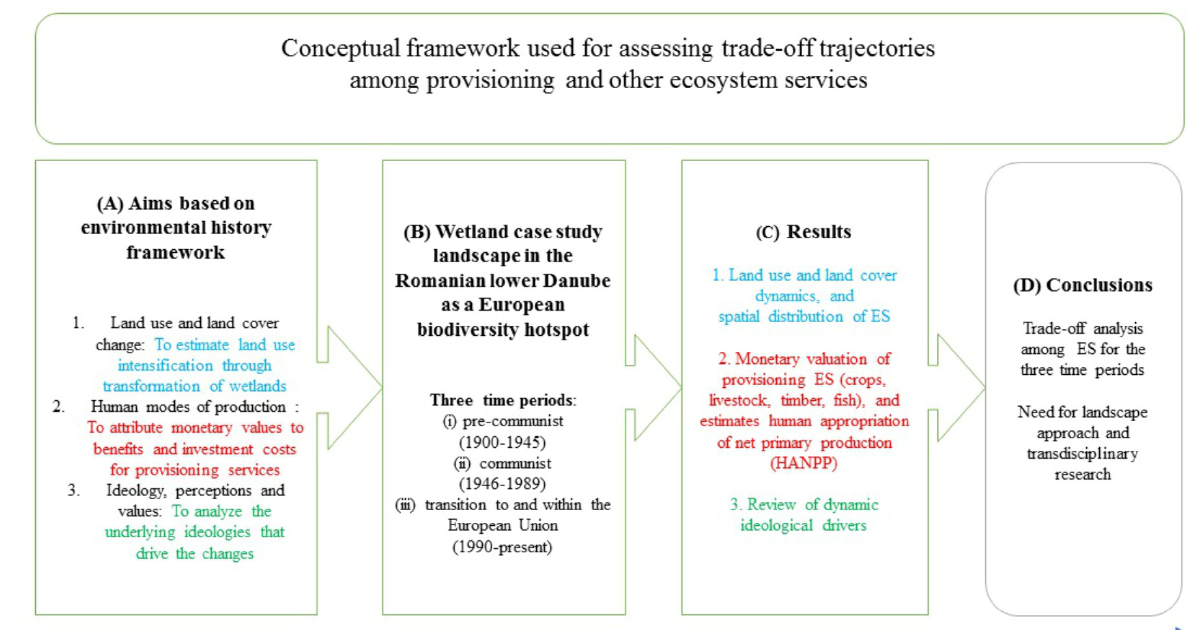
Figure 1. Overview of the research process that aimed to ( A ) analyse the three dimensions of Romania’s environmental history, including the transitional periods, by ( B ) selecting a case study landscape in Romania’s lower Danube. Beginning in 1900, the time period selected for this study was divided into three. This study ( C ) addresses the three research questions in order to meet the three aims outlined in ( A ). Finally, ( D ) we discuss the trade-offs between provisions and other ES. We also discuss the need for transdisciplinary social-ecological research and landscape approaches which could form the basis for landscape